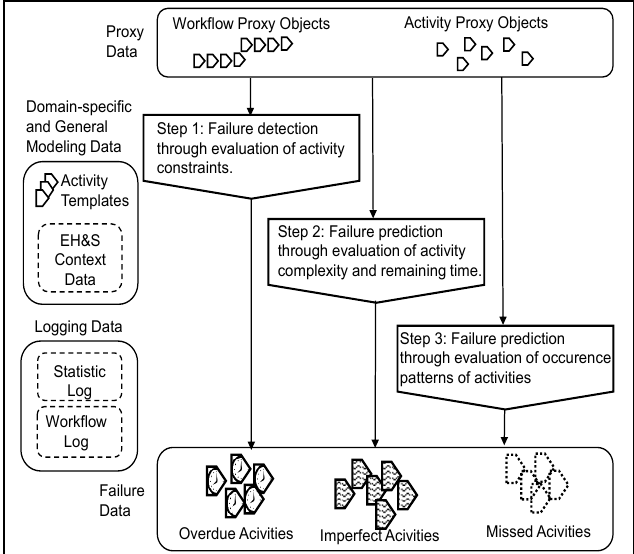
Fig. 2. Principles of failure detection and prediction approach.